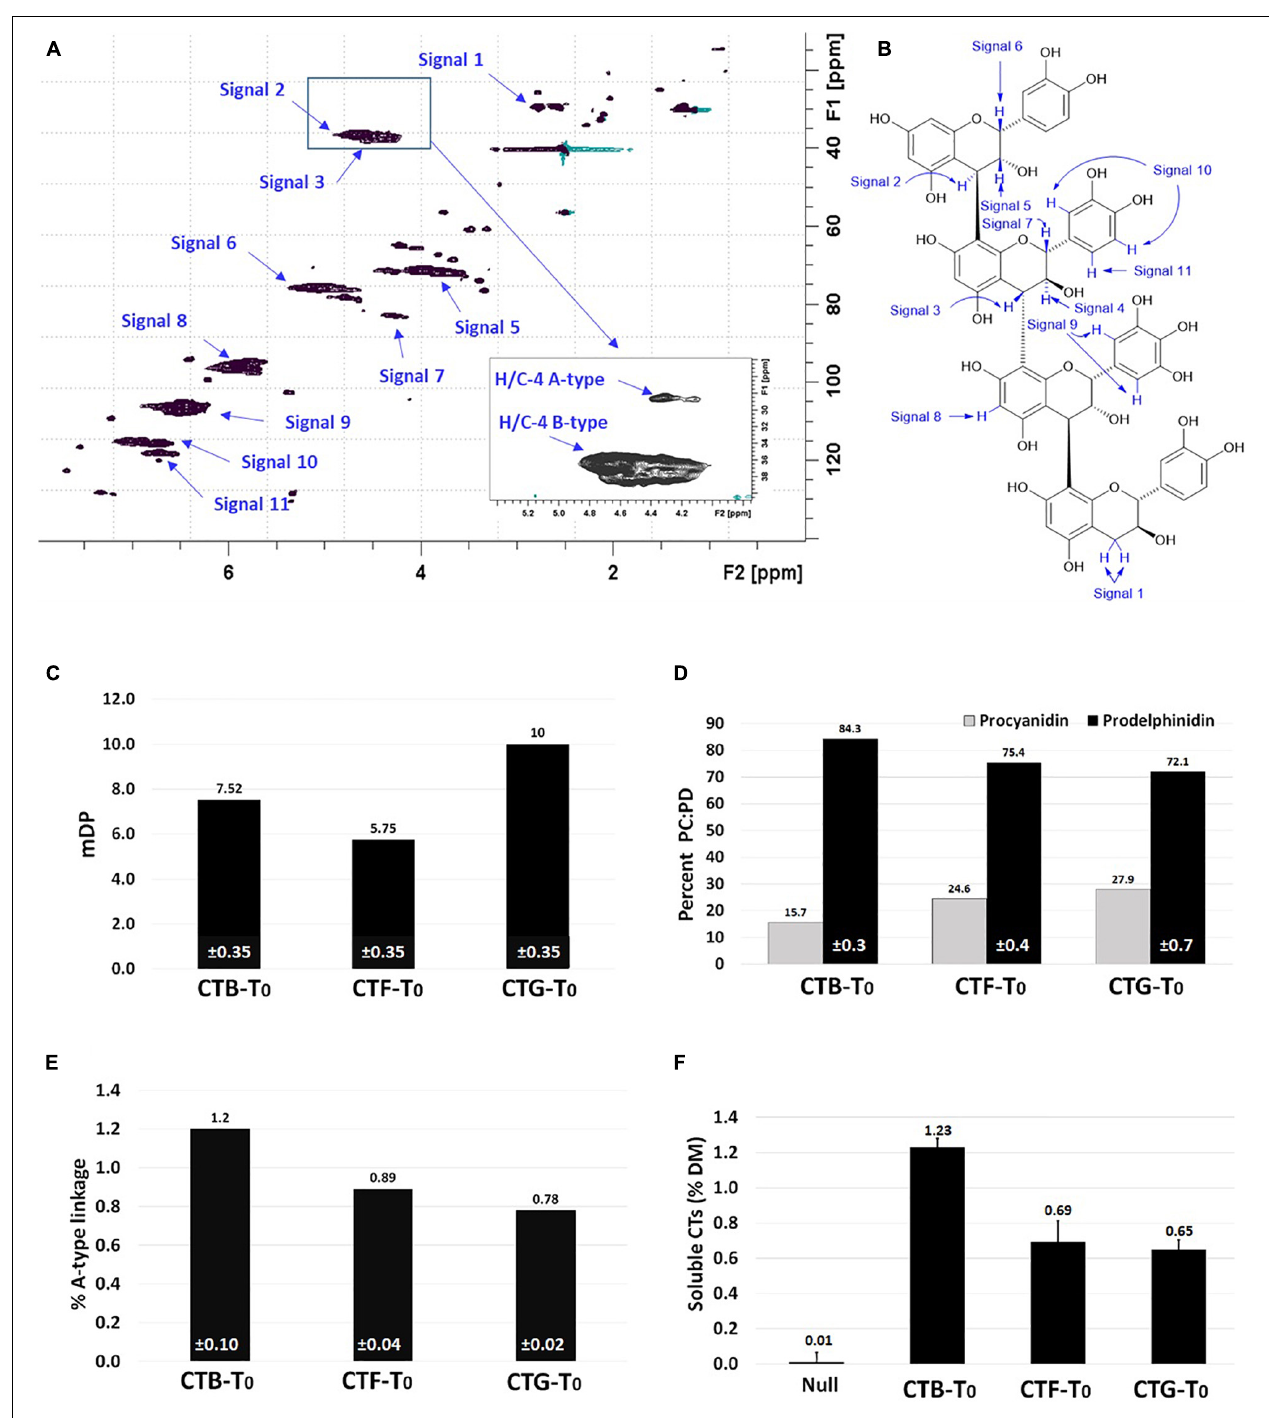
FIGURE 4 | Composition of purified CTs from the leaves of three primary transgenic events. (A) A representative 1 H- 13 C HSQC NMR spectrum of soluble condensed tannins (CTs) from a primary transgenic event (CTB-T 0 ) with (B) assigned cross-peaks; (C) a mean degree of polymerization (mDP); (D) the proportion of procyanidin to prodelphinidin (PC:PD) in leaf CTs; (E) percent A-type linkage in CTs from three primary events, and (F) soluble CTs in the 3 primary events expressed as percent dry matter (DM) of epigallocatechin (EGC) equivalents. The inserted box in panel (A) shows an expanded and higher intensity view of the H/C-4 A-type and H/C-4 B-type cross-peaks present in the CTs from CTB-T 0 . The comparative integration of these cross-peaks allows for the proportion of A-type linkages present to be determined. Similarly, the additional composition of the purified CTs was determined through the integration of respective cross-peak volumes (Zeller et al., 2015b; Naumann et al., 2018). The ± values at the base of each bar in panels (C–E) are standard deviations from three separate measurements of the same spectrum. Error bars in panel (F) represent the standard error of the mean of soluble CTs from three independent harvests at 4, 8, and 12 weeks after planting.